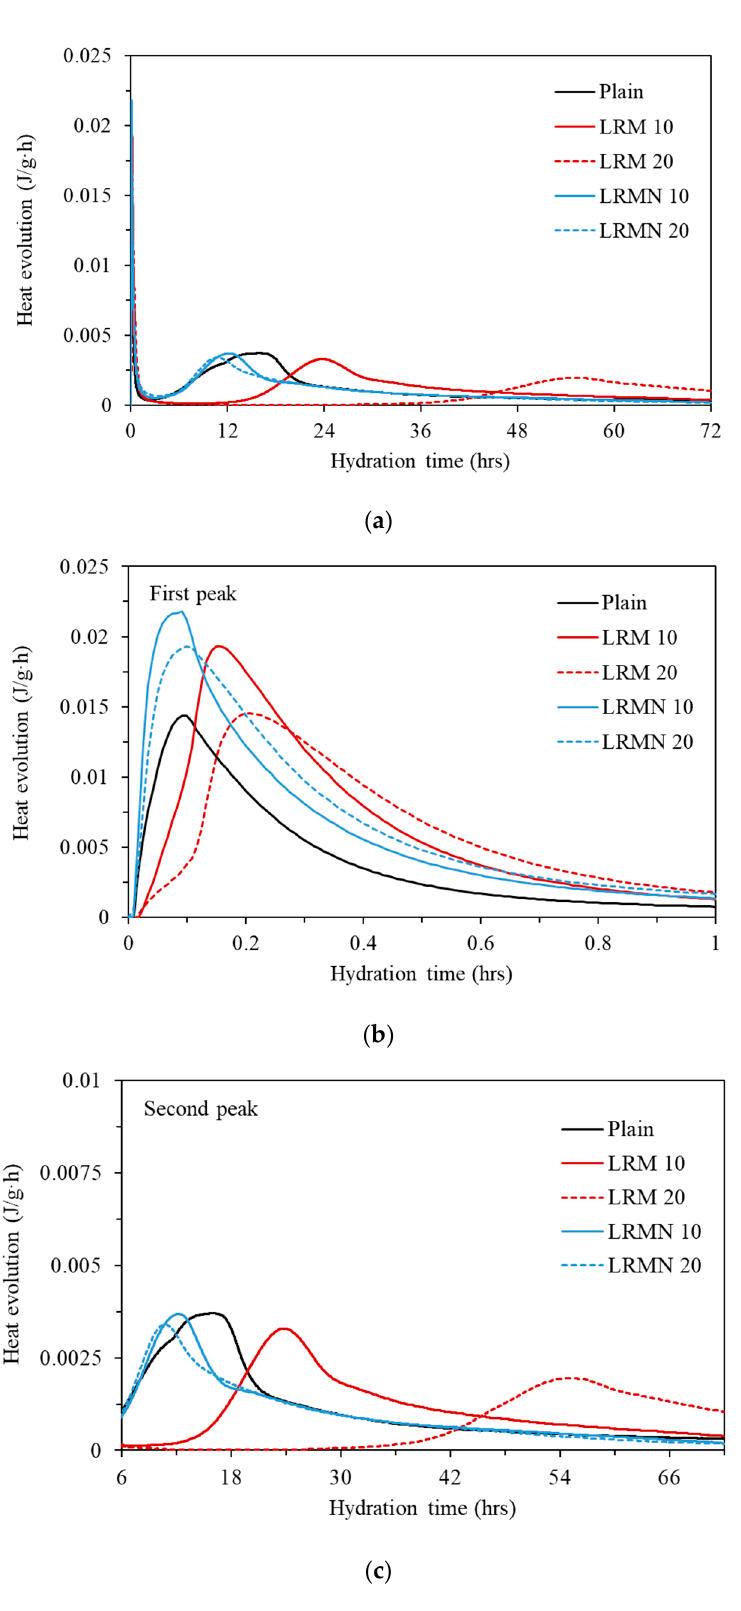
Figure 6. ( a ) Heat evolution rates of the various cement paste samples. Magnified view of the ( b ) first peak and ( c ) second peak in ( a ).